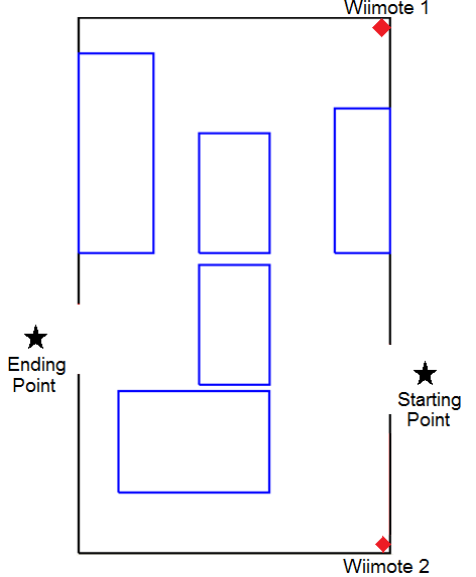
Figure 11. Distribution ―A‖ of the experimentation